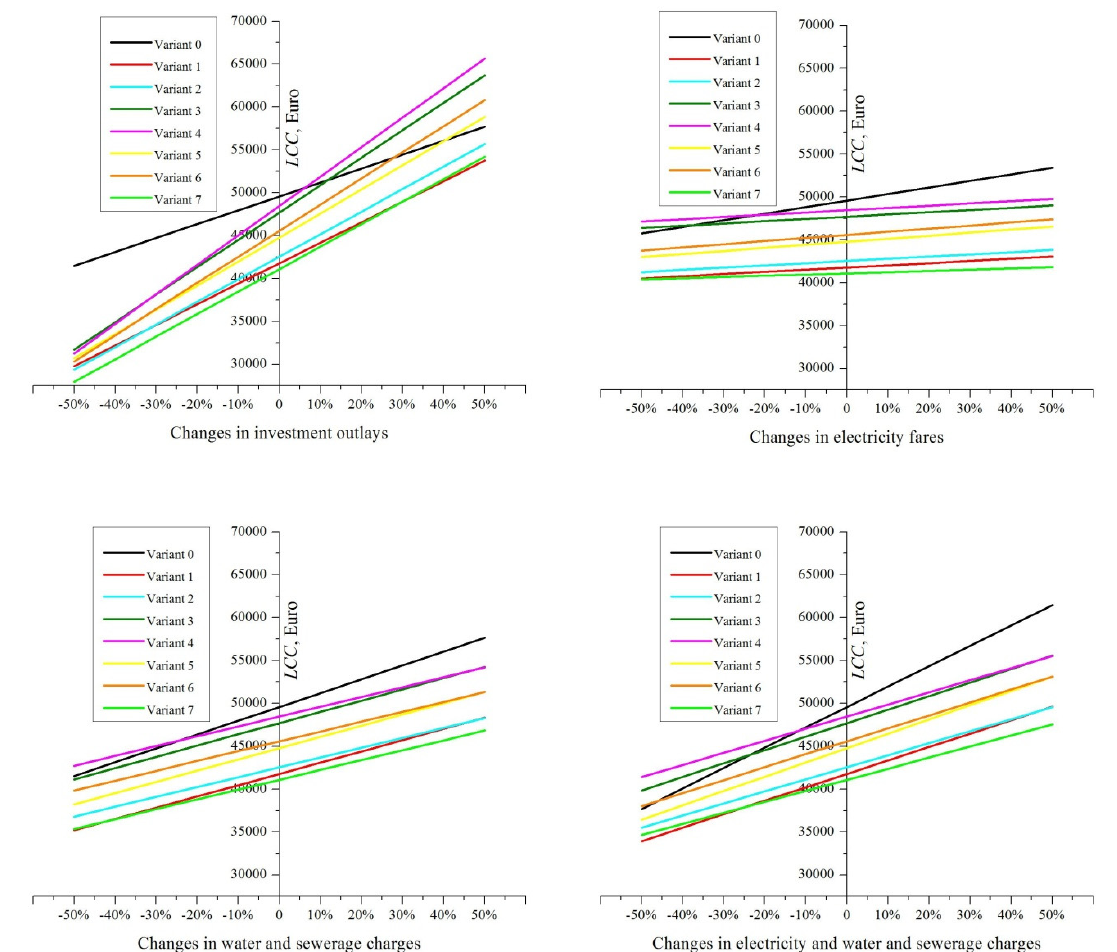
Figure 15. Graph of LCC ratio dependence on percentage changes of analyzed variables for the case: O c = 4 persons and l sh = 8 min/person/day.